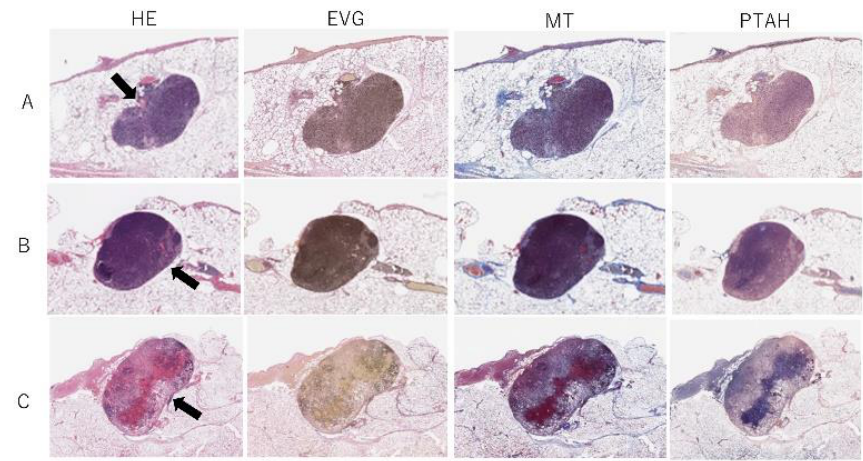
Figure 7. Histological findings of ( A ) control, ( B ) ischemic, and ( C ) congestive lymph nodes (LNs). Black arrows in hematoxylin and eosin stain indicate hilar sites: ( A ) The control LNs maintained their internal structure. ( B ) In ischemic LNs, intravascular thrombus and intravascular fibrin deposition were observed in the medulla. ( C ) In congestive LNs, erythrocyte agglutination and fibrin deposition were observed in vascular areas near the hilum and in the marginal sinus. Moreover, inflammatory cells were observed around the clot in the marginal sinus. HE, hematoxylin and eosin; EVG, Elastica van Gieson; MT, Masson’s trichrome; PTAH, Phosphotungstic acid hematoxylin.